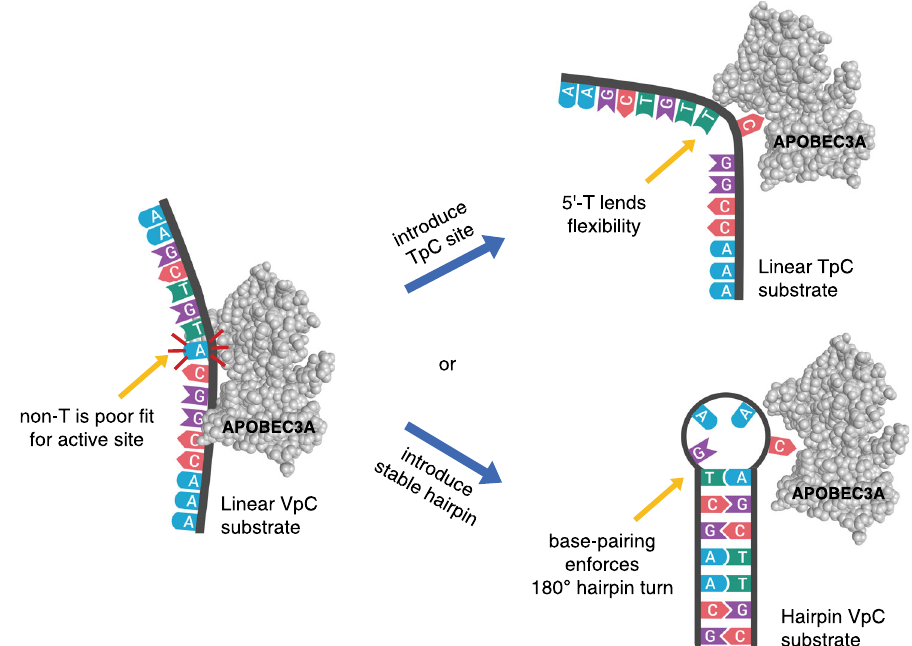
Fig. 7 Determinants of APOBEC3A substrate optimality. Linear (non-hairpin) DNA substrate containing a VpC sequence has both non-optimal sequence and non-optimal structure, causing it to be a poor substrate for APOBEC3A. However, improving either the primary sequence (top path) or secondary structure (bottom path) improves the overall substrate optimality and enables APOBEC3A activity. Changing the VpC sequence to TpC enables productive contacts between the T and the enzyme, and may also increase fl exibility at the precise point where the DNA needs to bend to fi t into the A3A active site. Keeping the VpC sequence but changing the structure to a hairpin prepays the entropic cost of bending the DNA at the 5 ′ site, enforcing a 180-degree hairpin turn. (Figure created with